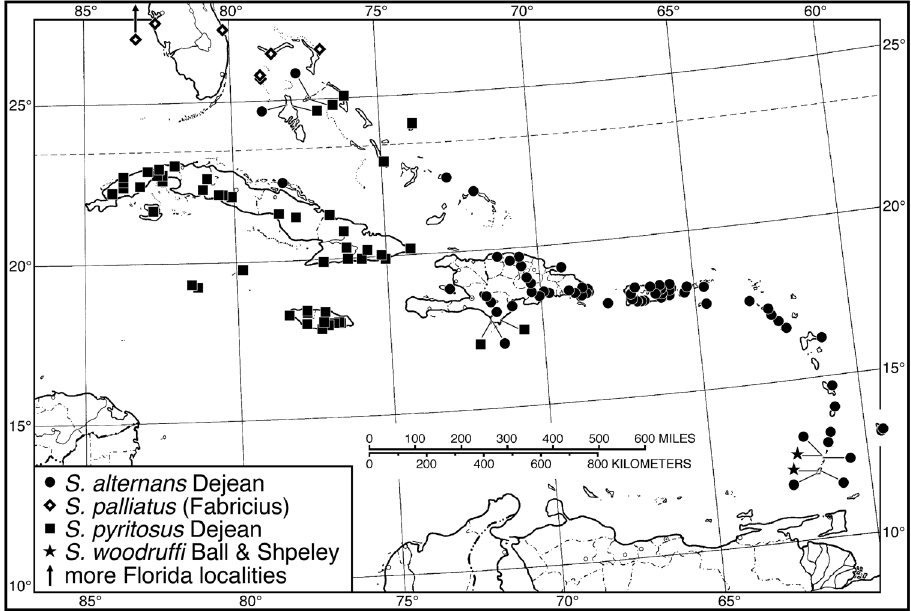
Figure 53. Map of West Indies showing known localities for species of Selenophorus palliatus species